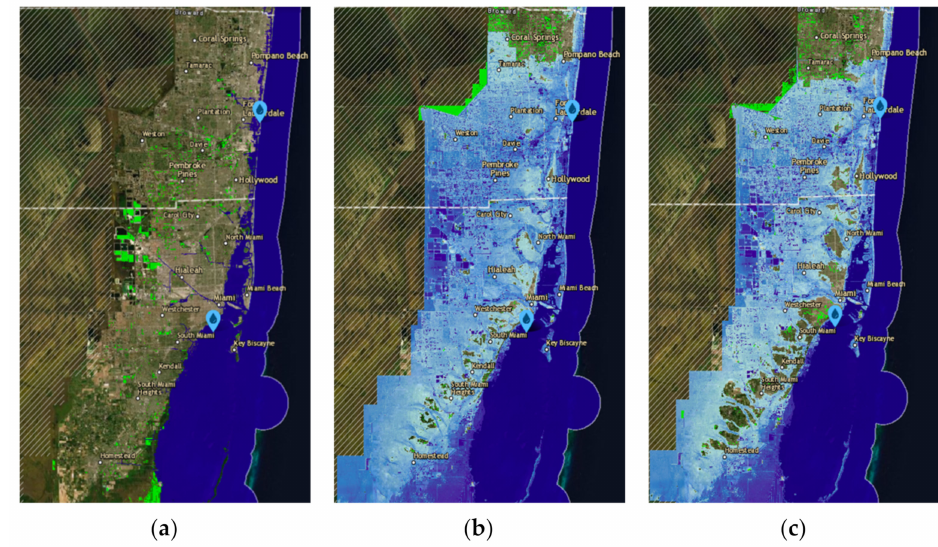
Figure 12. ( a ) Here we show sea level at the present day (2021); ( b ) predicted extreme flooding by 2050 and ( c ) 2100 in Miami, Florida, and surrounding cities.